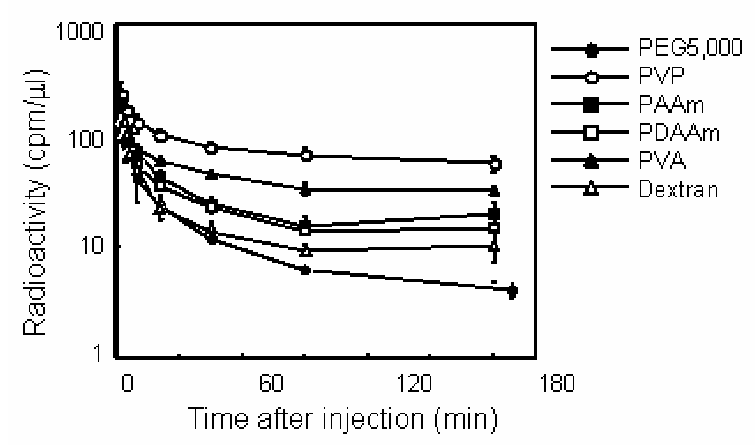
Figure 4. Plasma clearance of various water-soluble polymers in mice bearing S-180 solid tumors after i.v. injection. Mice were intravenously injected with 125I-labeled polymer. After administration, blood was collected from the tail vein at indicated times and the radioactivity was measured by a γ -counter. Mice were used in groups of five. Each value is mean ±